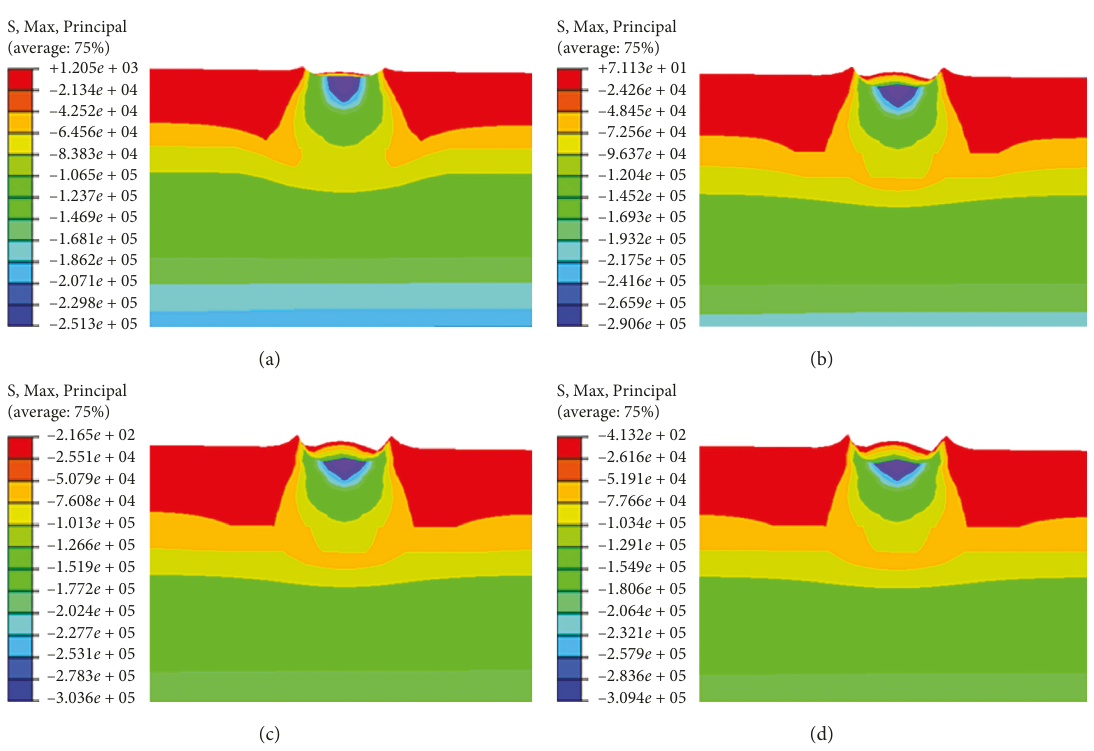
Figure 12: Maximum principal stress cloud. (a) First strike. (b) Third strikes. (c) Fifth strikes. (d) Seventh